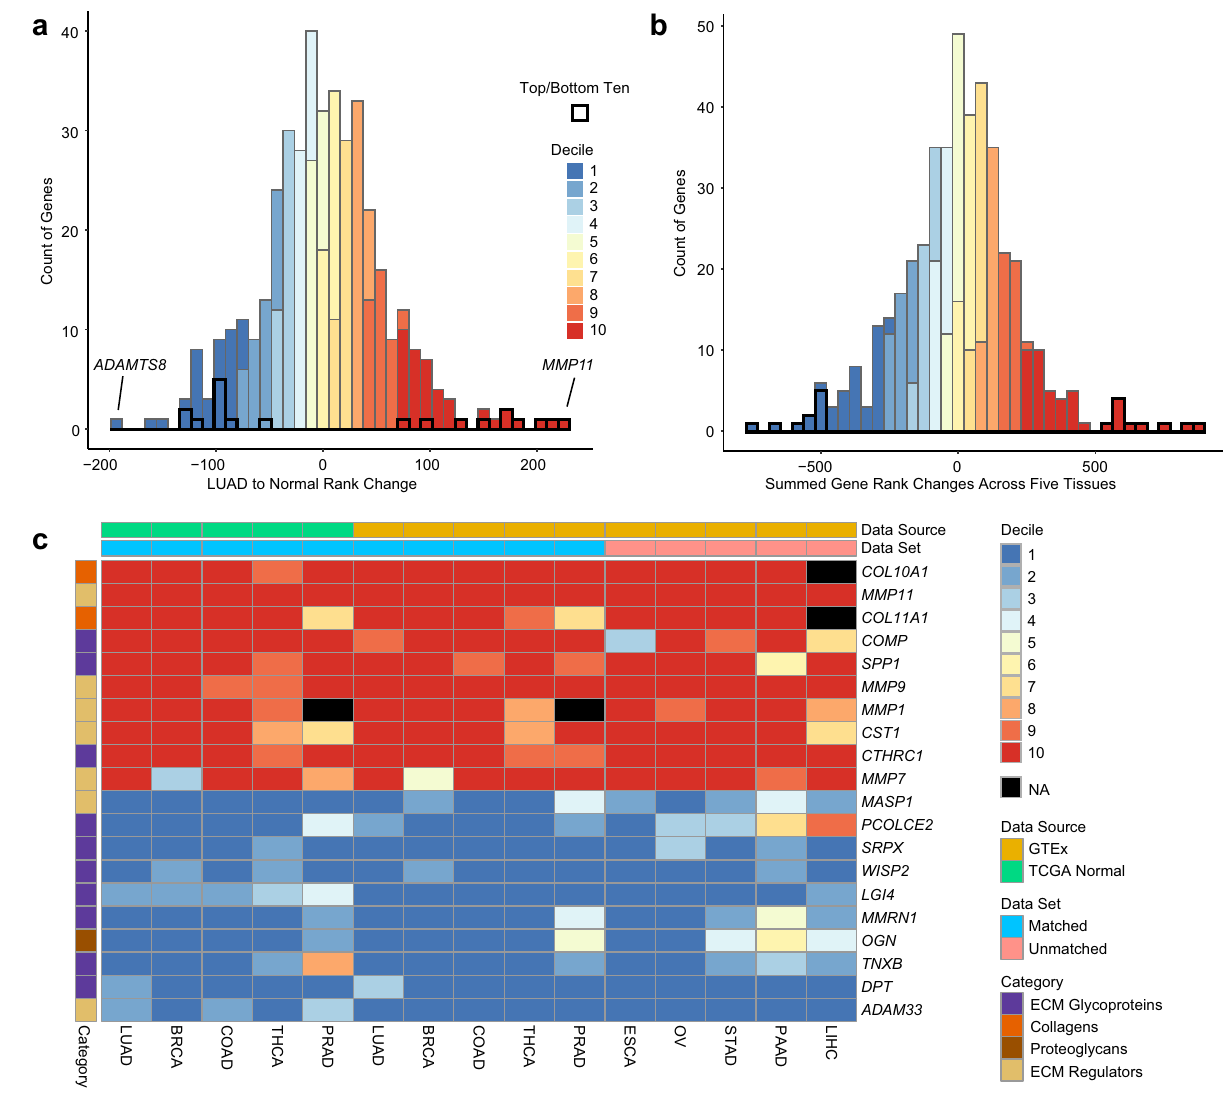
Figure 4. Commonly upregulated and downregulated matrisome gene transcripts. ( a ) A histogram of transcript rank changes between combined TCGA normal samples (n = 110) and GTEx samples (n = 374) compared to TCGA cancer samples (n = 542) in lung. The histogram is colored on the decile of rank change. ( b ) A histogram of the sum of normal to cancer rank changes for gene transcripts across lung, breast, colon thyroid and prostate (n = 443). The histogram is colored on the decile of rank change. ( c ) A heatmap of the top and bottom rank-changed matrisome gene transcripts between normal tissue and cancer. The rank change order is split into deciles, (1—1st decile to 10—10th decile). NAs are represented by black boxes and indicate no expression in the normal or cancer